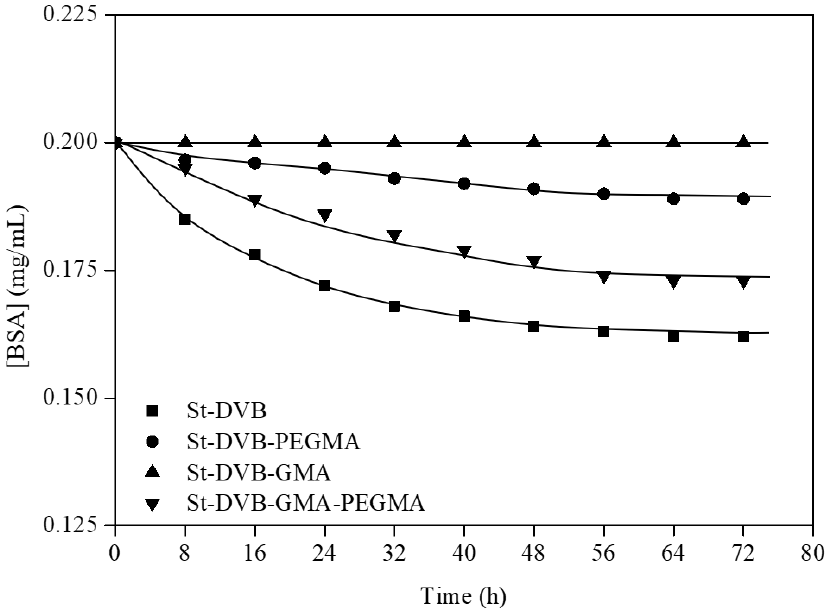
Figure 3. Kinetics of BSA immobilization in St-DVB non-pre-wetted particles. Wp = 2.5 g; T = 25 °C; t = 72 h and Fr = 8 mL/min.